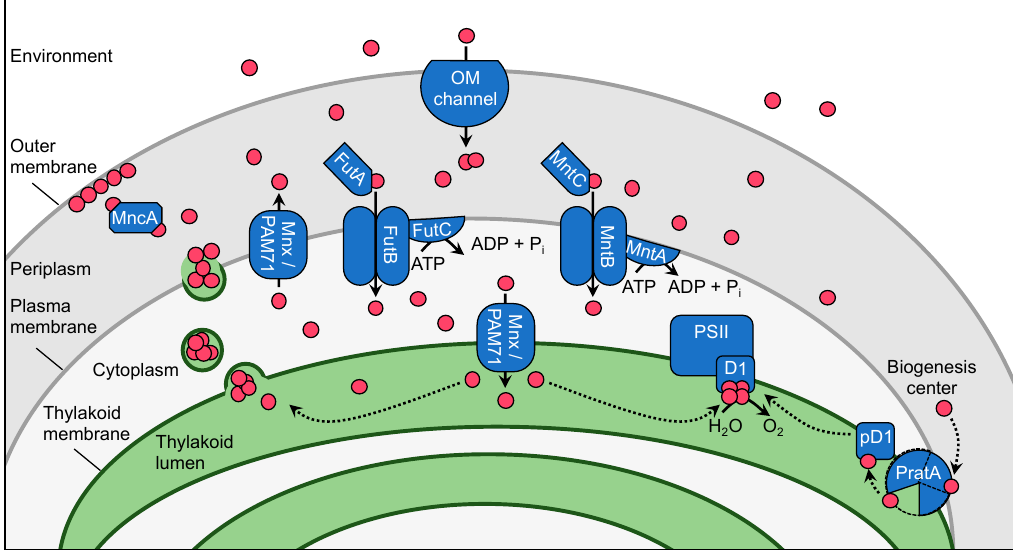
Figure 1. The Mn homeostasis network model for Synechocystis . Shown are proteins for which functions contributing to Mn homeostasis were assigned. Mn 2 + -ions are displayed as pink-colored circles. For simplification, the two-component regulator system ManS / ManR was omitted and has been presented separately in Figure 2. Mn is primarily taken up from the aquatic environment in its Mn 2+ ionic form via a light-dependent transport process through outer membrane (OM) channels. It accumulates in the periplasmic storage, either associated with the outer membrane or bound by Mn cupin A (MncA). From the periplasm Mn is imported into the cytoplasm on demand. The ABC-type transporter MntCAB serves the Mn import under Mn-limiting conditions, while FutABC is suggested to fulfil this function in a constitutive manner. In biogenesis centers PratA preloads pre-D1 with Mn 2+ - ions from the periplasmic storage. Alternatively, thylakoid membrane located Mnx/PAM71 assists in lumenal Mn supply to PSII. Mn is excreted into the periplasm by Mnx/PAM71 or possibly vesicle formation from the thylakoid system.